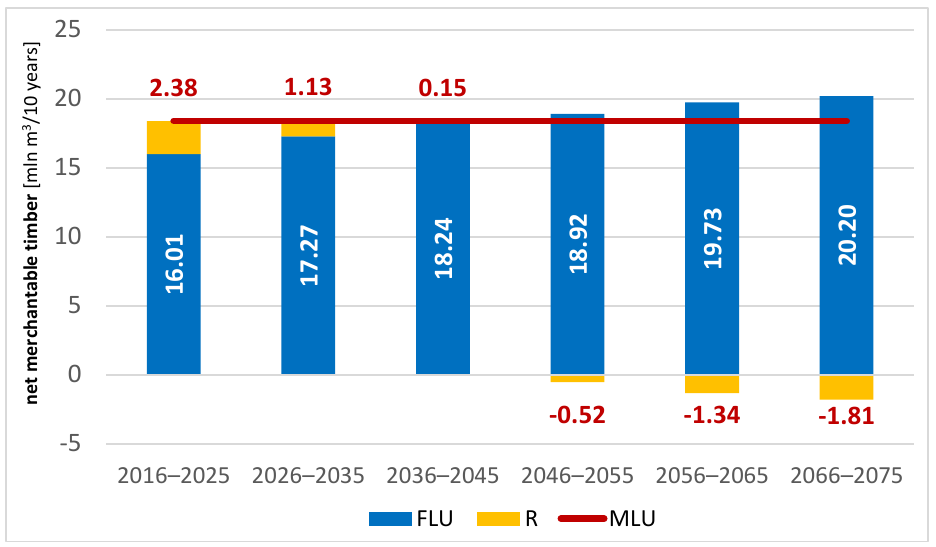
Figure 2. The discrepancies (R) between the average (MLU) and the forecast scope of cuts (FLU) in the period of 2016–2075.